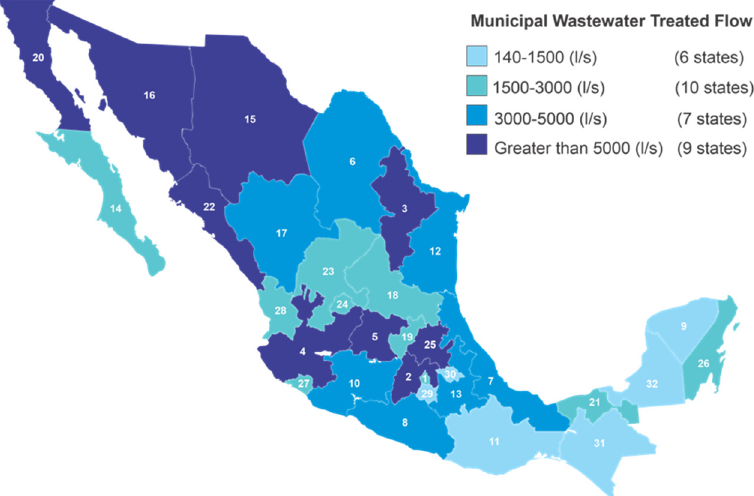
Figure 2. Treated municipal wastewater flow rate by 32 states in Mexico based on CONAGUA data [8] and the National inventory of municipal drinking water and wastewater treatment plants in operation